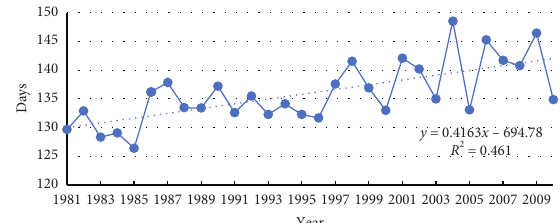
Figure 4: The annual average tourist climate comfortable period in mainland China